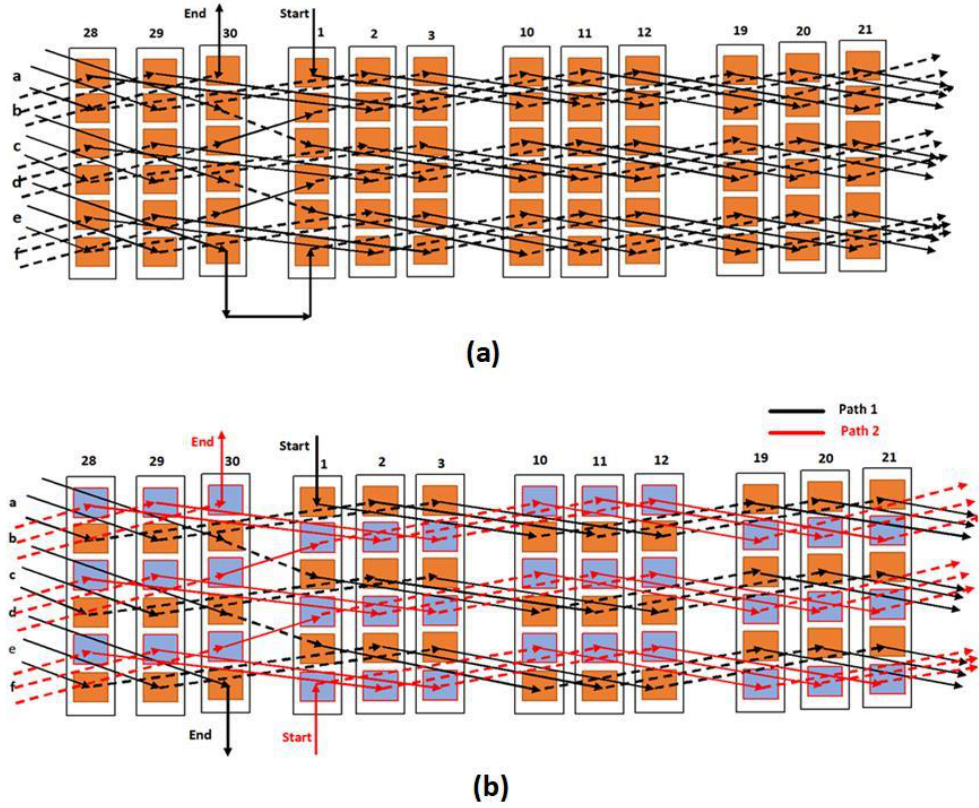
Figure 2. Feasible hairpin configuration of a three-phase, six-layer hairpin winding layout for a 36-slot, four-pole stator: ( a ) one path, ( b ) two parallel paths [3]. According to Equation (1) and (2), the number of stator slots per phase is q m = 12, and the number of slots per pole per phase is q = 3. Figure 2a shows the connection of the winding layers ( n w ) with one parallel path per phase ( N aa = 1), and the number of series turns per phase ( N st ) is calculated as follows [16]: